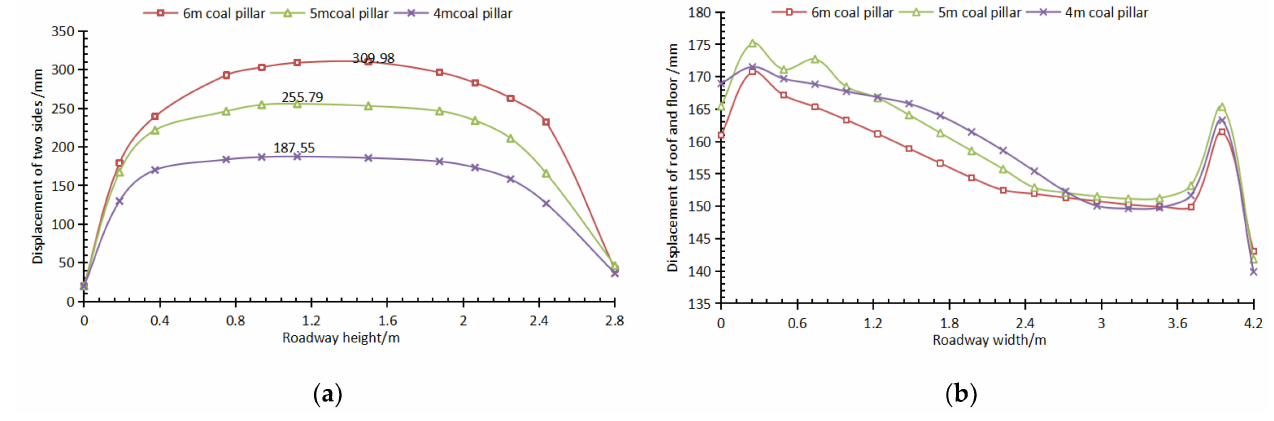
Figure 12. Deformation curve of the roadway surrounding rock with coal pillars of different sizes: ( a ) displacement of two sides of the roadway; ( b ) displacement of the roof and floor of the